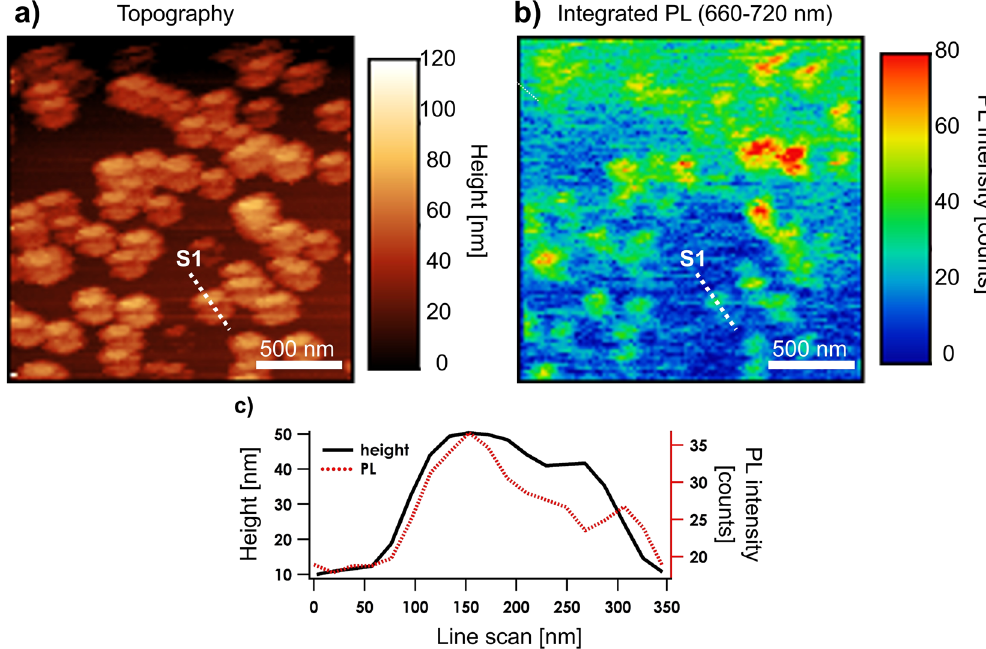
Figure 4. Near-field scan results. Correlated height map ( a ) and integrated PL map (2 × 2 µ m 2 ) ( b ) of isolated 40 nm diameter fluorescent beads obtained using an imprinted campanile probe. ( c ) Line scans from the topography and PL